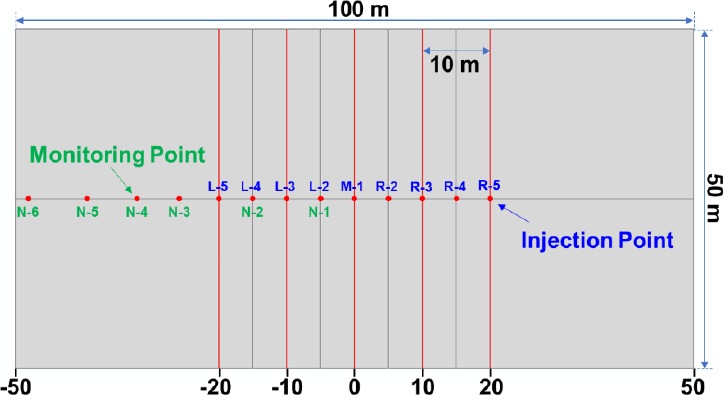
Figure 6. Schematic diagram of the geological model.